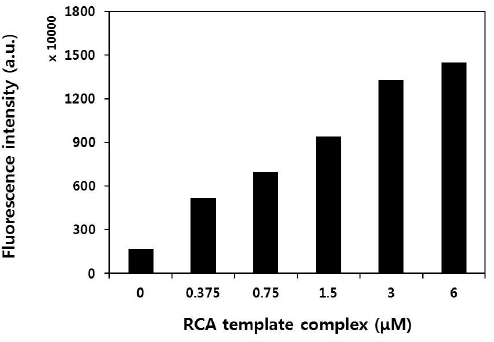
Figure 2. Rolling circle amplification (RCA) reaction test using various concentrations of circular template–(T)12 primer complex.